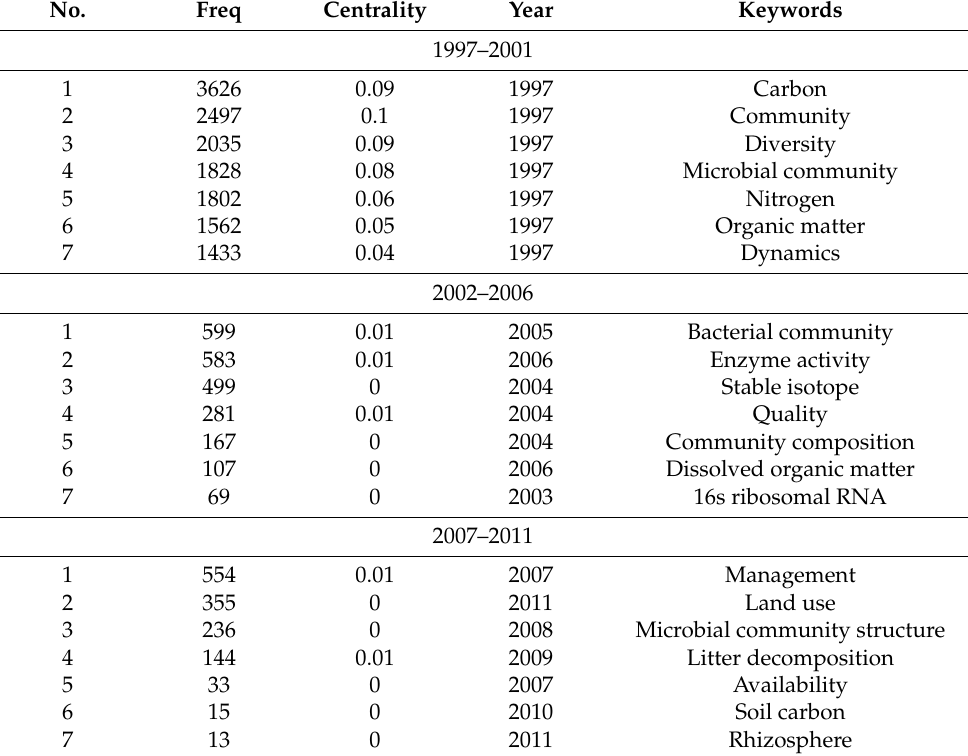
Table 10. The top 7 high-frequency keywords of papers published on the ZCC every five years during 1997–2022. No. Freq